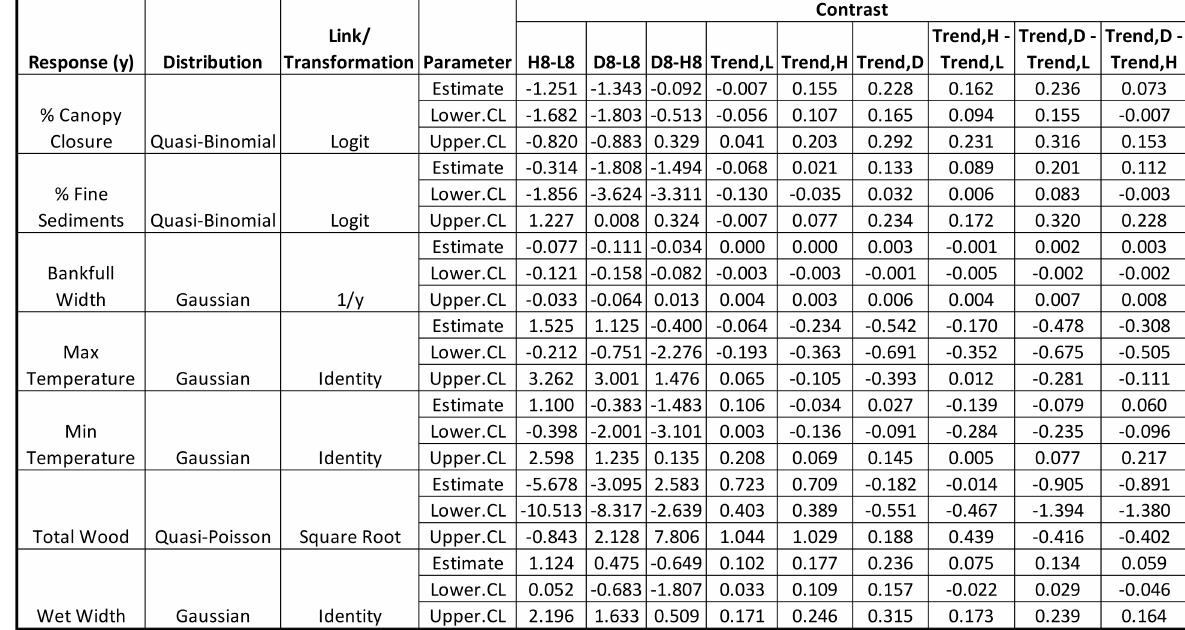
Figure A3. Contrasts of abiotic characteristics from 2008 to 2016 at low flood ( L ), high flood ( H ), and debris flow ( D ) disturbance categories. First set estimate difference between each category immediately after storm, the second the difference trend at H, L, and D and the third comparing